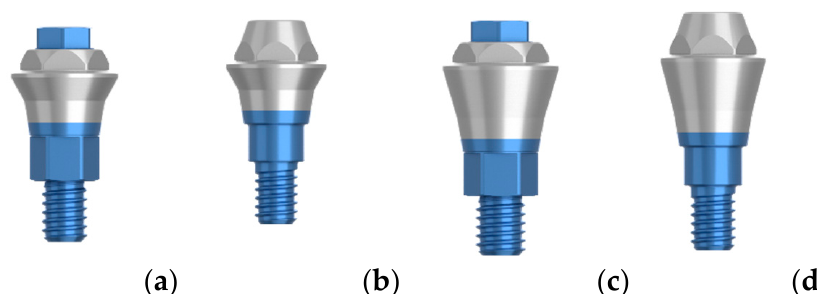
Figure 1. ( a ) Permanent 1 mm unit; ( b ) permanent 1 mm multiple; ( c ) permanent 2 mm unit; ( d ) Permanent 2 mm